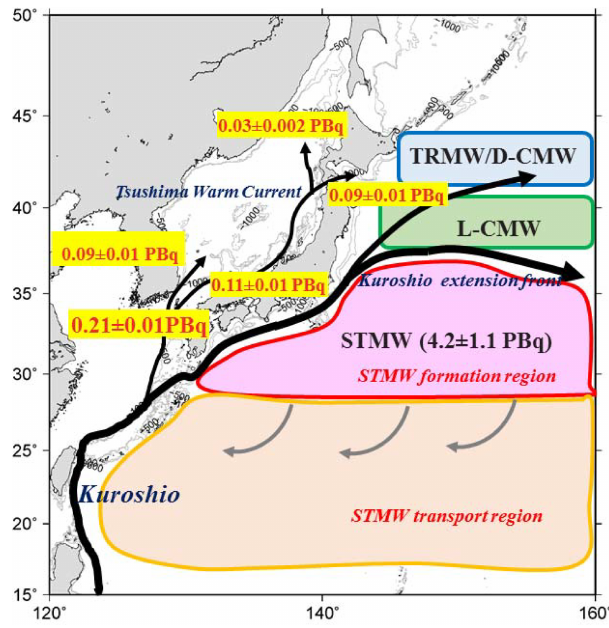
Figure 8. Schematic diagram of the FNPP1-derived 137 Cs transport in the North Pacific Ocean. The bold line indicates the Kuroshio pathway. The thin black lines indicate the flow pathway of the Tsushima Warm Current. The pink region is the STMW forma- tion area. The green region is the lighter variety of the CMW (L- CMW) formation area, and the blue region indicates the Transition Region Mode Water (TRMW) and the denser variety of the CMW (D-CMW) formation area. The estimated accumulated flux during the period from 2012 to 2016 at each section is shown. The inven- tory in the STMW was deduced by Kaeriyama et al.